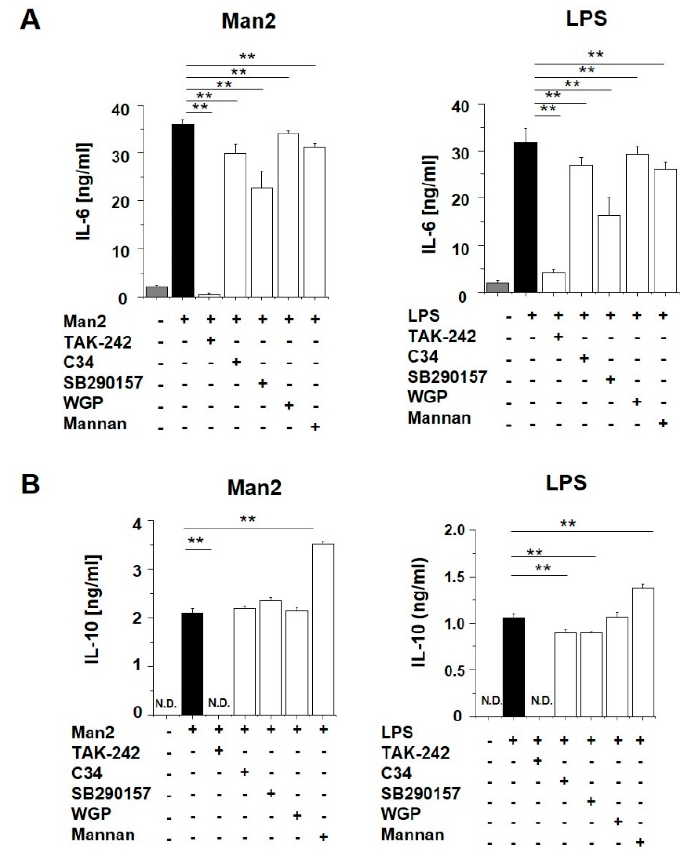
Figure 5. Effect of receptor inhibitors on IL-6 and IL-10 production of Man2-treated BMDCs. BMDCs derived from C57BL/6 mice (1 × 10 6 cells/mL) were treated with either 10 µ M TAK-242, 50 µ M C34, 100 µ M SB290157, 100 µ g/mL of WGP ® Soluble, or 200 µ g/mL of mannan for 30 min, and subsequently stimulated with 10 µ M Man2 or 1.0 µ g/mL of LPS for 24 h. The concentrations of ( A ) IL-6 and ( B ) IL-10 in the cell culture supernatants were determined by ELISA. ** p < 0.01 in Dunnett’s test. The data are representative for two independent experiments. All bar graphs show mean ± SD.